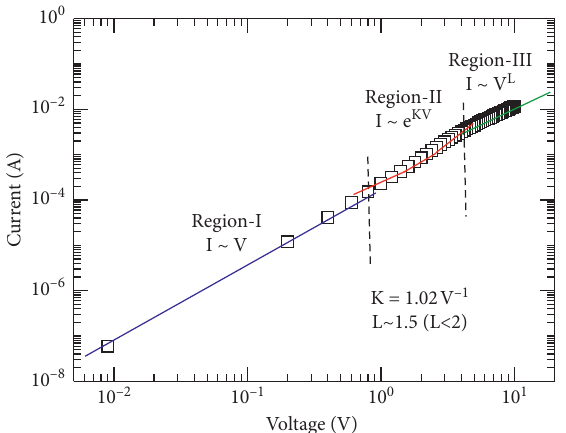
Figure 4: Log- I vs. Log- V characteristics of heterojunction.